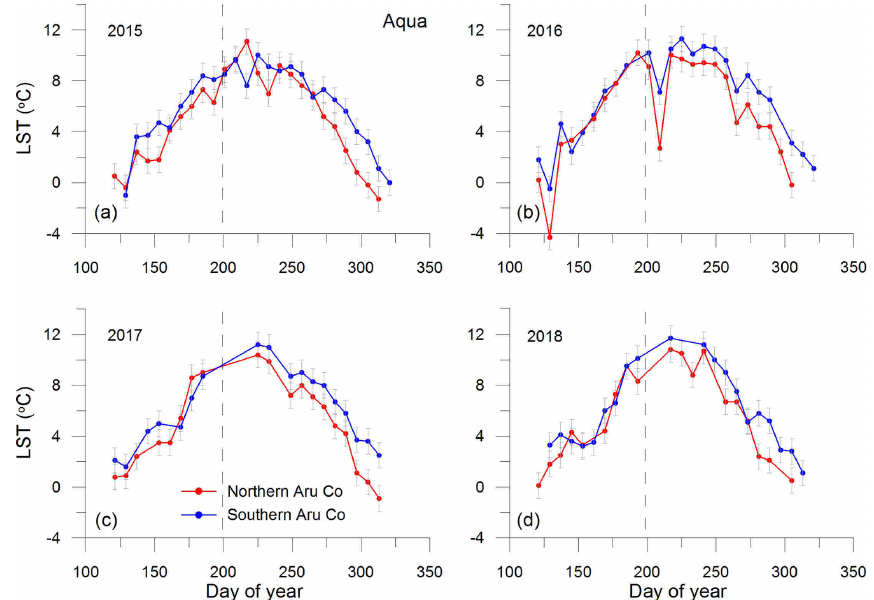
Figure 9. A comparison of MODIS-derived nighttime lake surface temperature (LST) in northern and southern Aru Co during the period of 2016–2019. The dashed lines indicate the time of the Aru-1 glacier collapse. The error bar is denoted in grey lines.